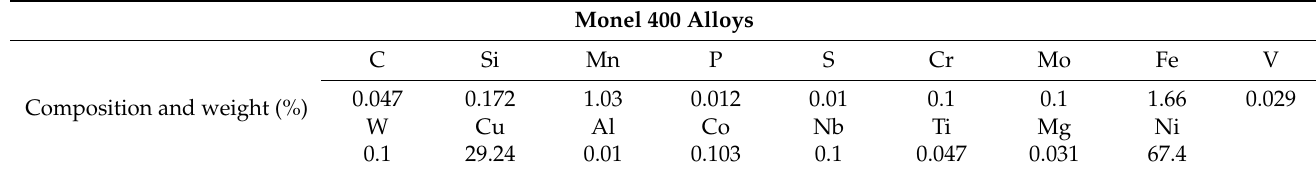
Table 1. Chemical composition of Monel 400 alloys. Monel 400 Alloys